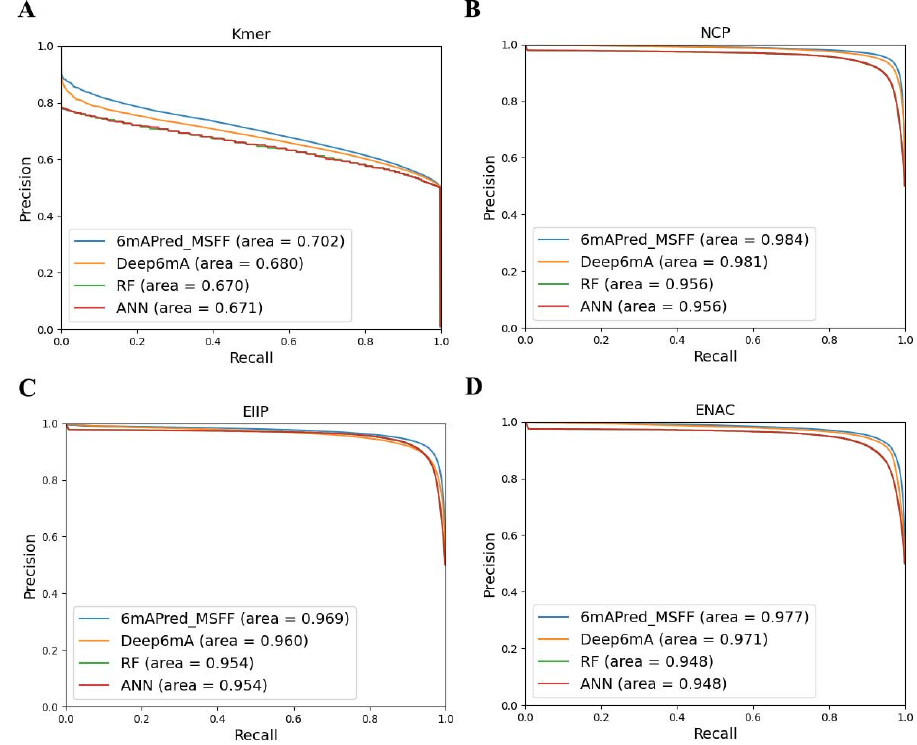
Figure 5. The PR curves ( A – D ) of four models (6mAPred-MSFF, Deep6mA, SNNRice6mA-large, and MM-6mAPred) based on four feature descriptors (Kmer, NCP, EIIP,